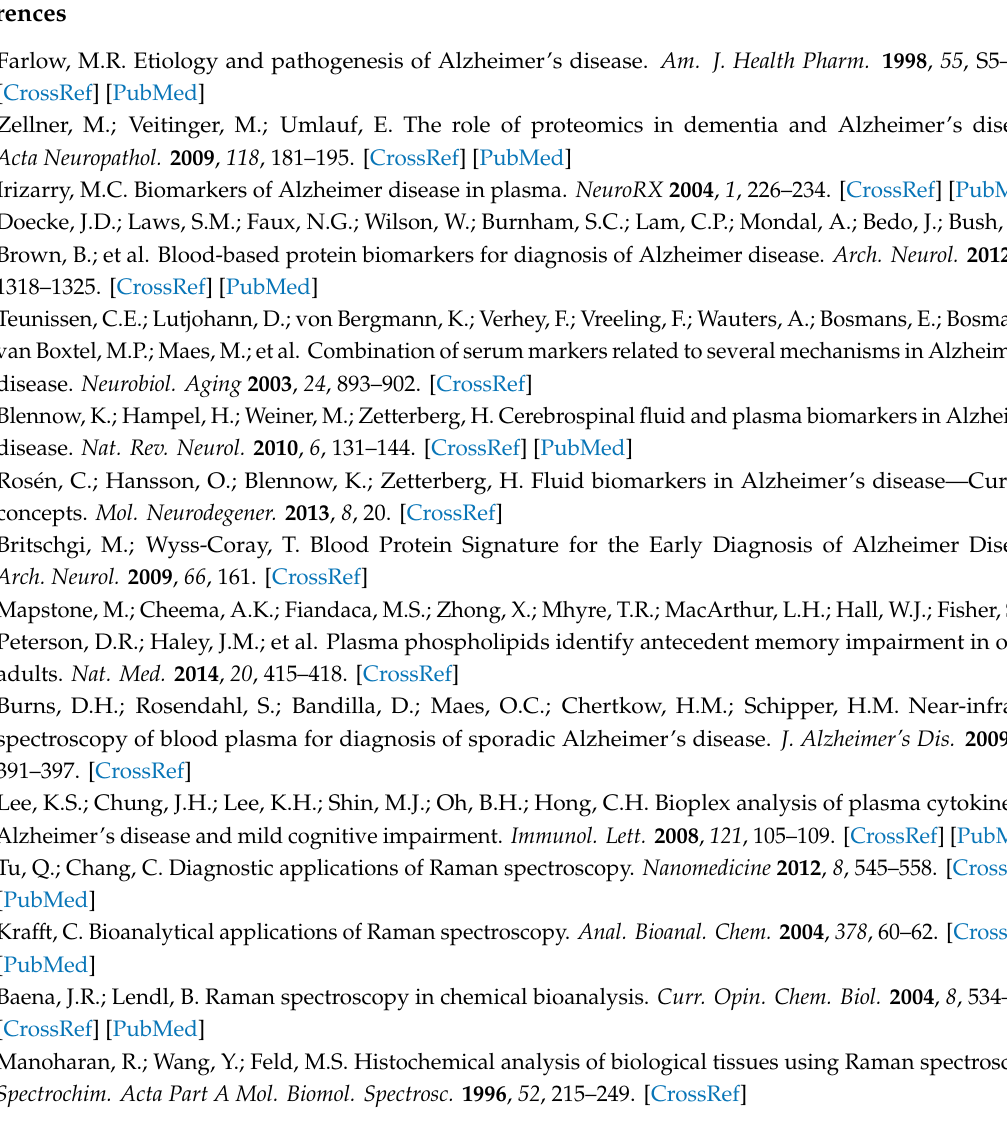
Figure S1: The di ff erence spectrum calculated between the di ff erent classes of average spectra, including ± 2 standard